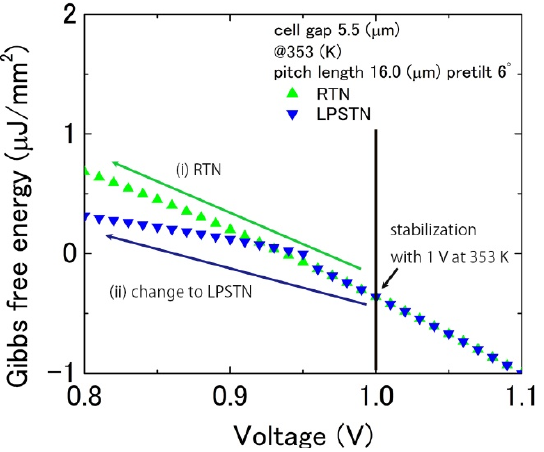
Figure 11. There are two routes from the RTN structure with application of 1 V at 353 K; (i) the RTN structure remaining, or (ii) changing to the LPSTN structure at low voltage.